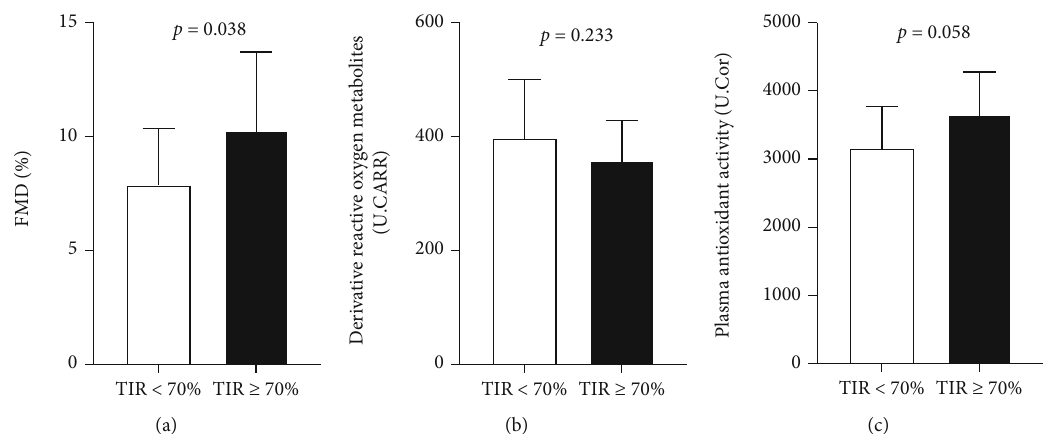
Figure 2: Impact of glycemic control on endothelial function and oxidative stress. FMD (a), d-ROMs (b), and PAT (c) values in patients with and without TIR > 70 % at 3 months in the overall population ( n = 32 ). FMD: fl ow-mediated dilation; d-ROMs: derivative reactive oxygen metabolites; PAT: plasma antioxidant test.